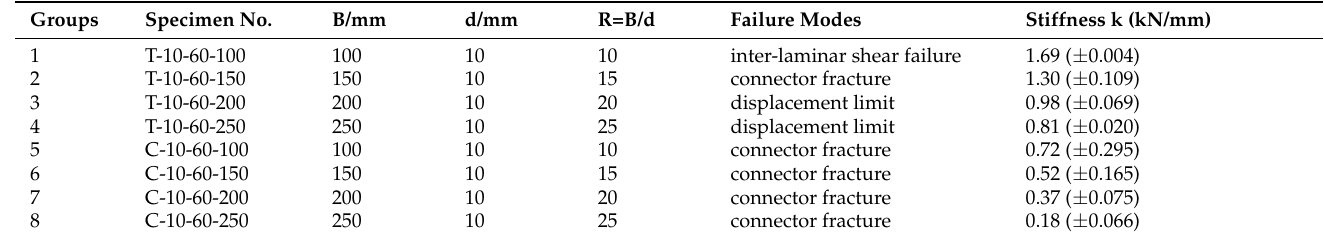
Table 5. Failure modes and stiffness of specimen with different span ratios.